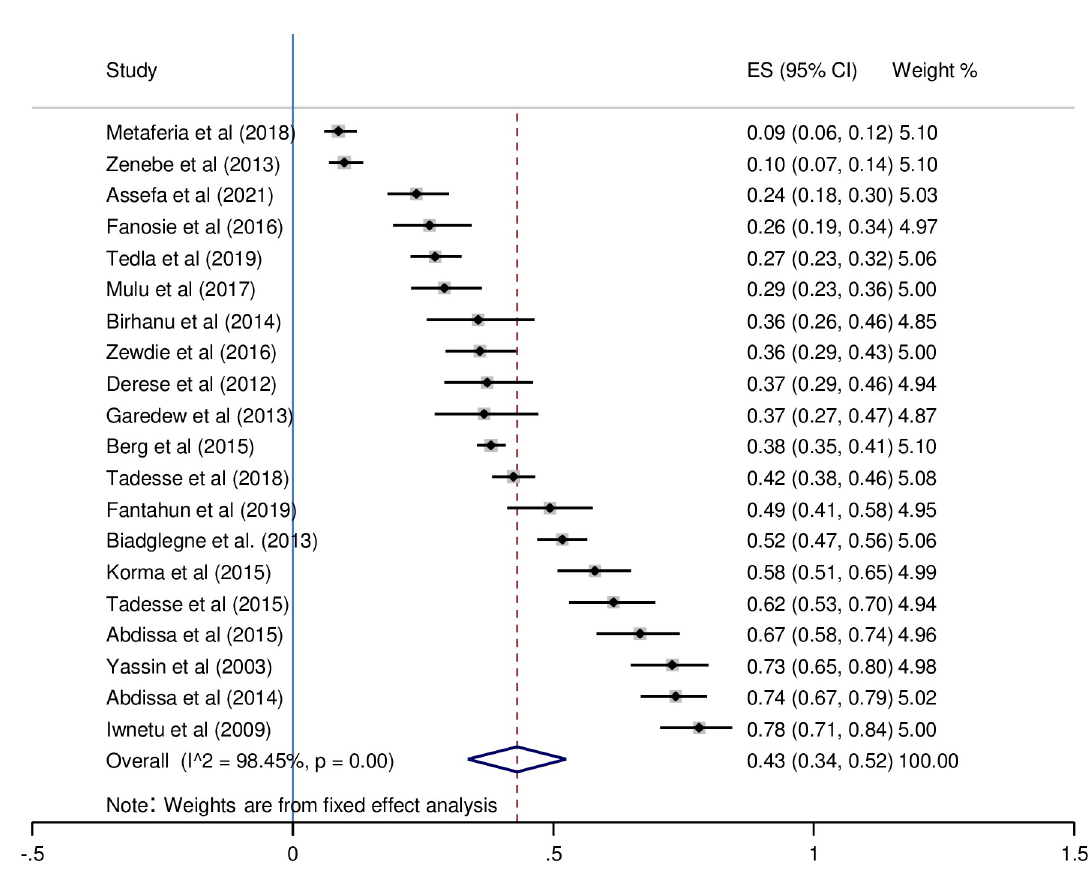
Fig 2. The pooled proportion of bacteriologically-confirmed EPTB cases amongst all studies identified for review.